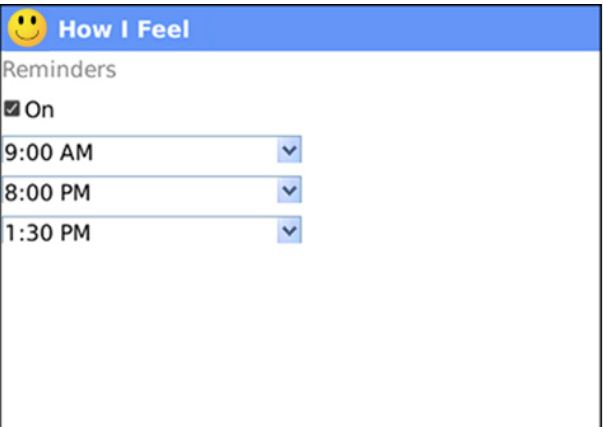
Figure 11. Reminders: The trackers use employ alarm-type entry reminders, which provide convenient ways to prompt clients to engage in health behaviors like exercise, dietary modifications, stress reduction, and self-reported mood. Reminders can be turned on and off easily by health coach and/or